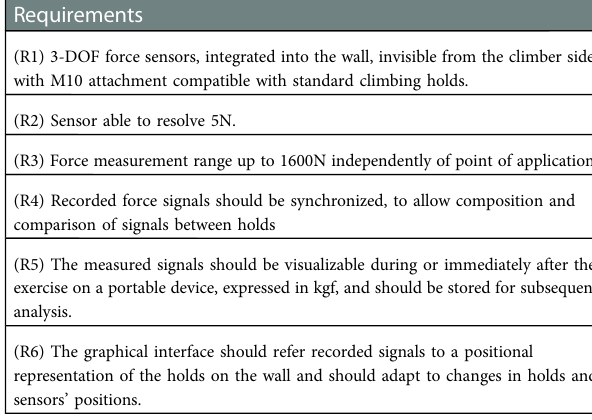
TABLE 1 An overview of the main requirements identi fi ed through the